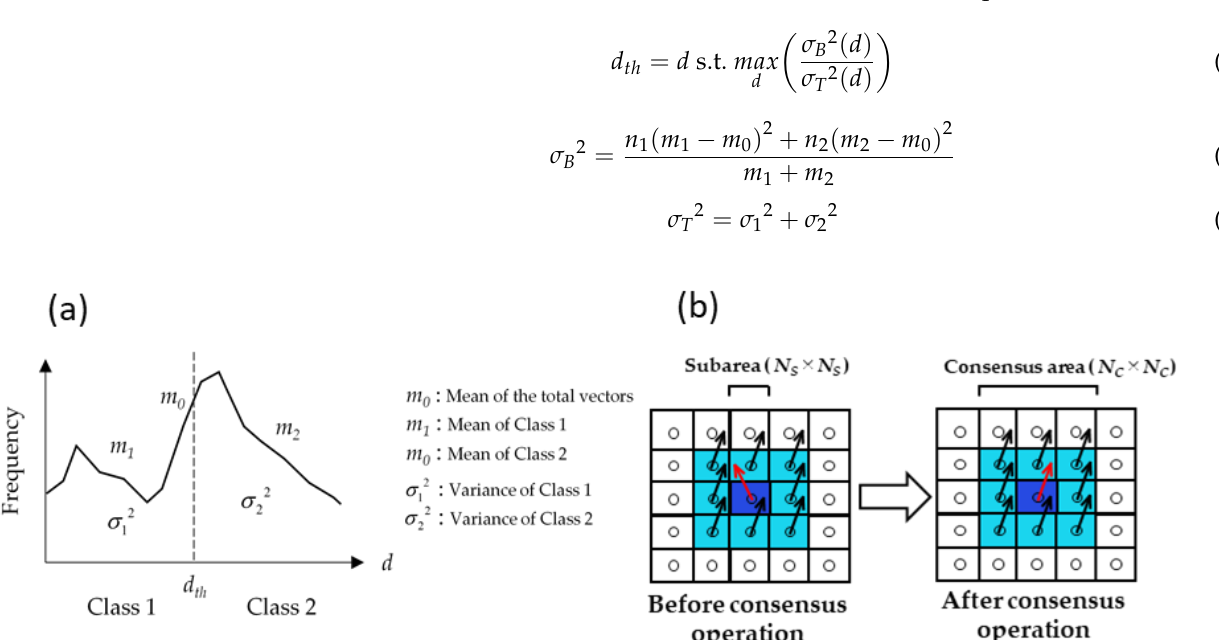
Figure 8. Schematic diagrams of ( a ) the histogram of shifting vectors and thresholding ( b ) present how the direction of generated shifting vector (red arrow) is corrected in the same way as the neighboring arrows using the consensus operation, modified from [21] .